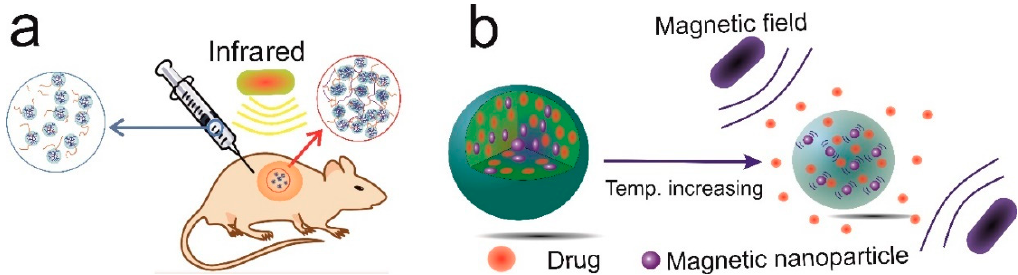
Figure 2. ( a ) Infrared ‐ responsive nanocarriers for in ‐ situ forming hydrogels as a drug delivery system and tissue scaffold and ( b ) magnetic fields and temperature ‐ responsive nanocarriers for increasing drug release.